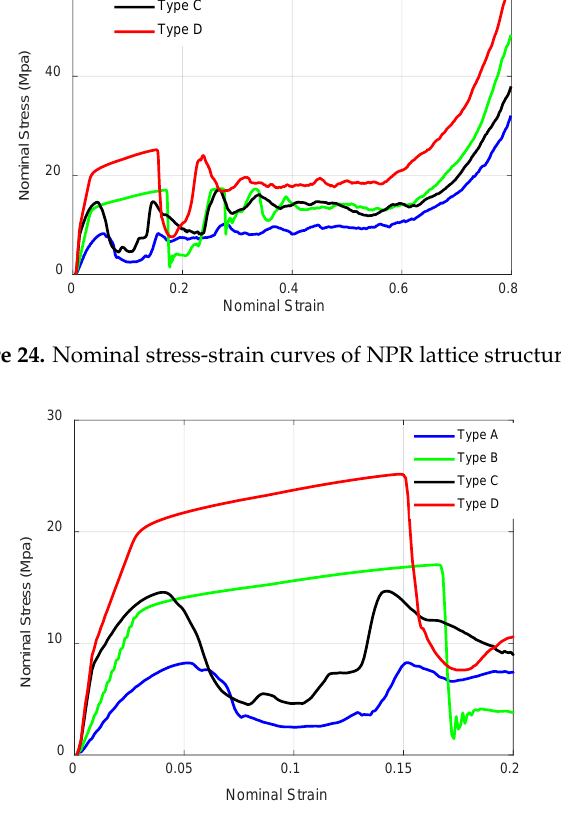
Figure 25. Nominal stress-strain curves of NPR lattice structures (strain range from 0 to 0.2).